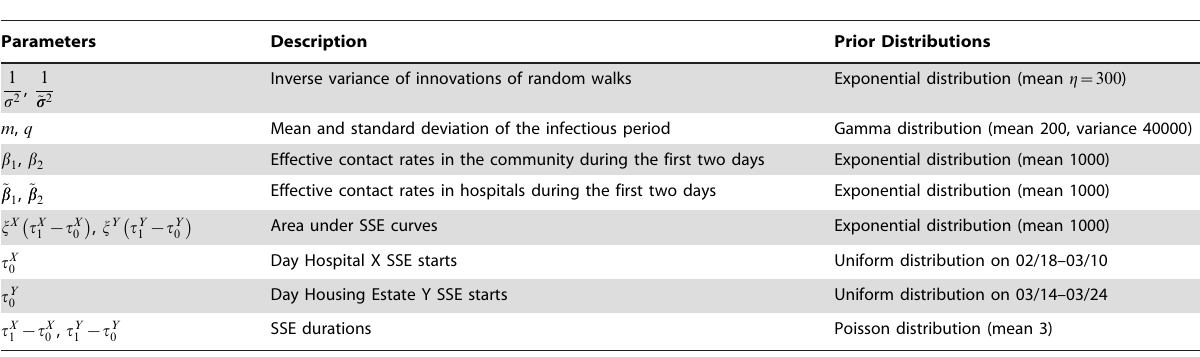
Table 1. Prior Distributions for Model